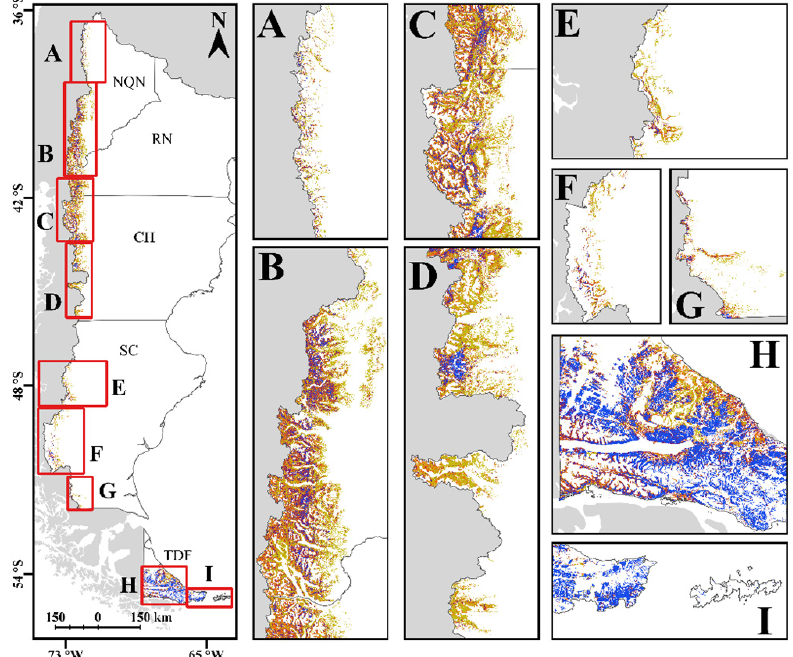
highest (12%). ( A – I ) figures are zoom to forest sectors of the whole Patagonia region (left figure).